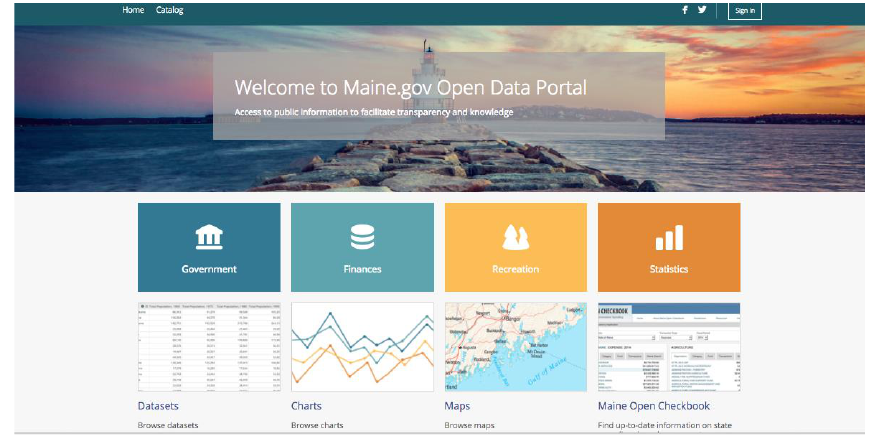
Figure 2: Front page of Maine open data portal, July